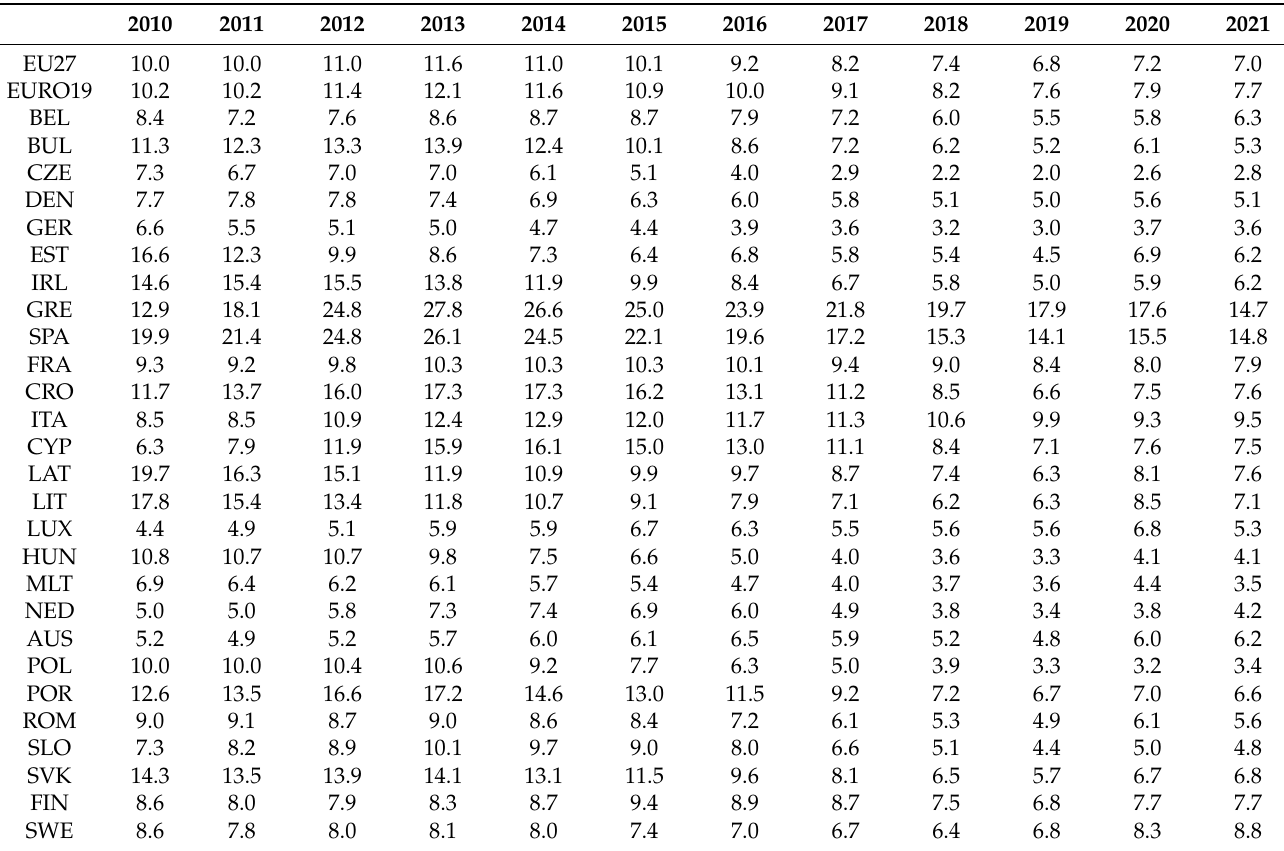
Table 3. Total unemployment rate EU27 2010–2021